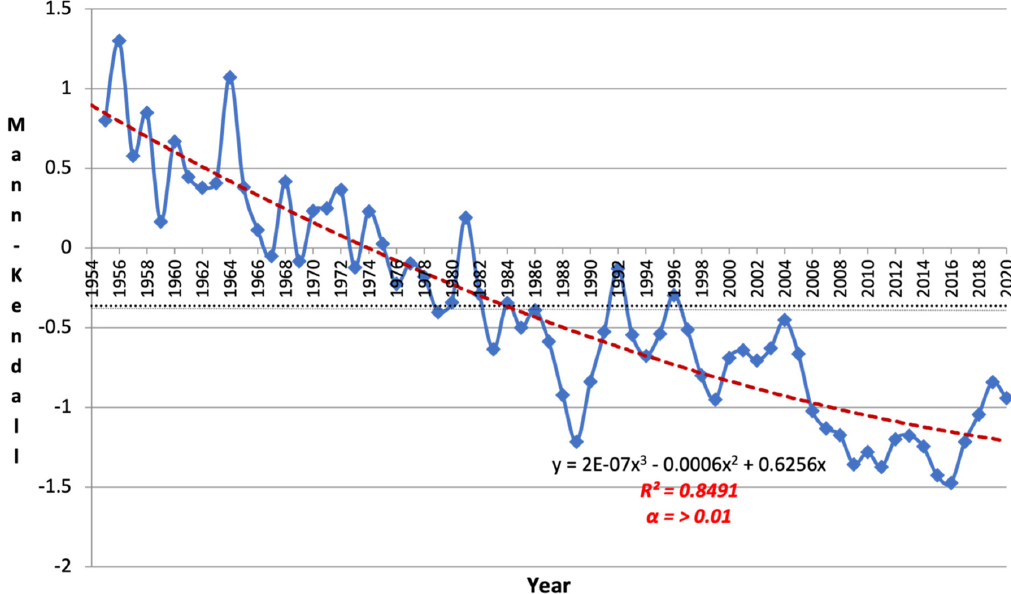
Figure A3. Value of the Mann–Kandall statistic for a time series from 1954 up to a particular year (blue dot). The red dashed line is a third-order polynomial fit (the equation) to the data.